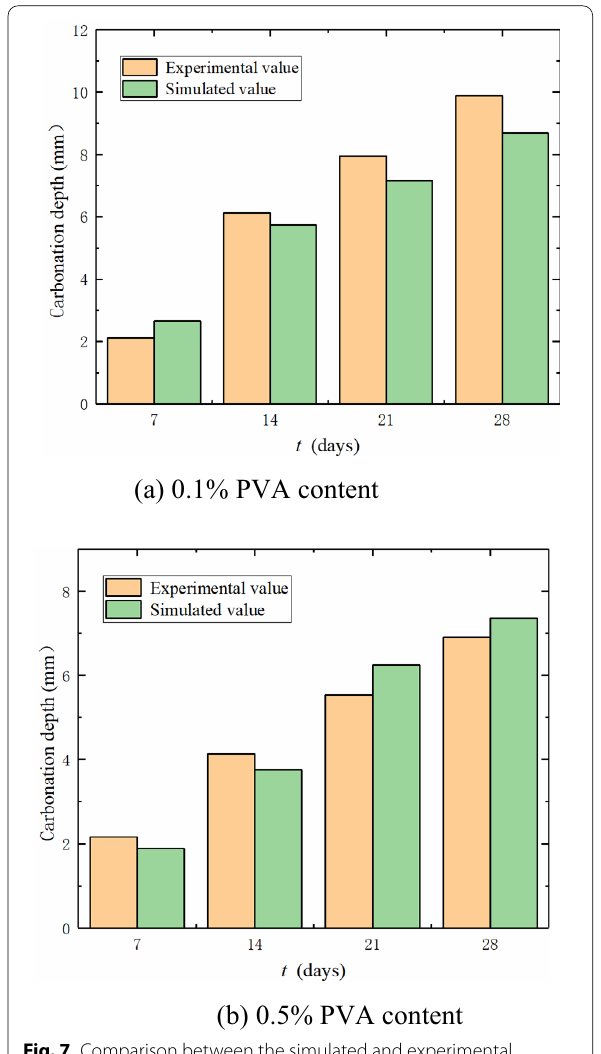
Fig. 7 Comparison between the simulated and experimental carbonation depth values of PVA fiber concrete with 3 mm fiber length and different contents.